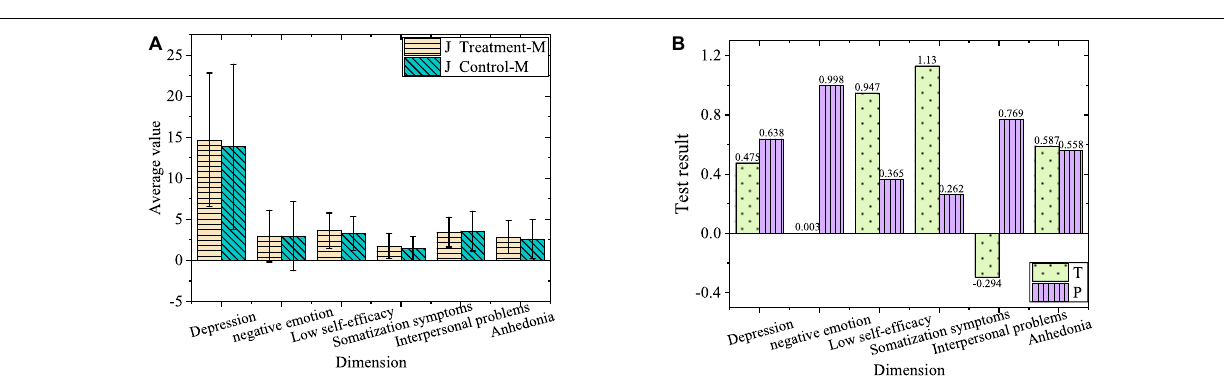
Frontiers in Psychology |